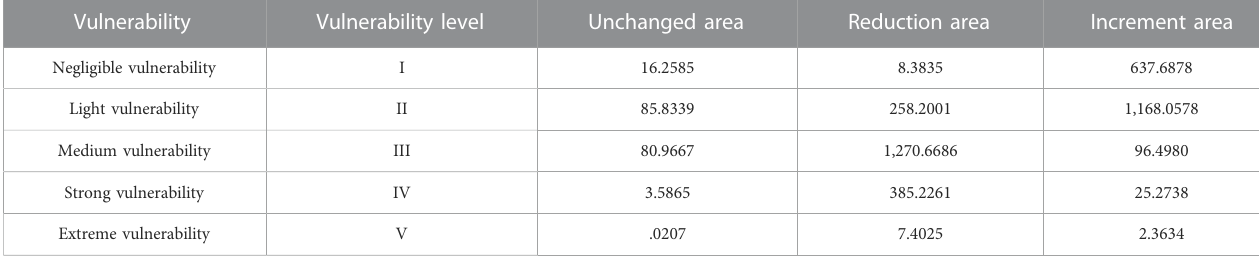
TABLE 7 Dynamic change of area of different ecological vulnerability levels from 2002 to 2016 (km 2